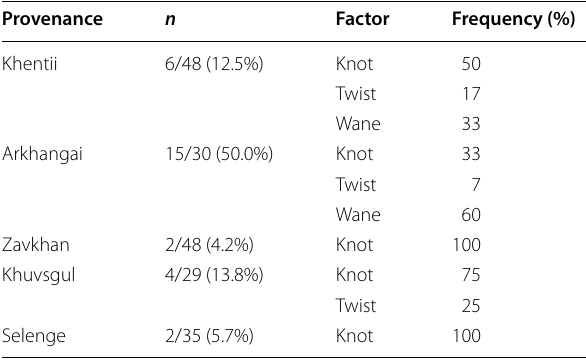
Table 8 Factors of lumber classified into outgrading in each provenance